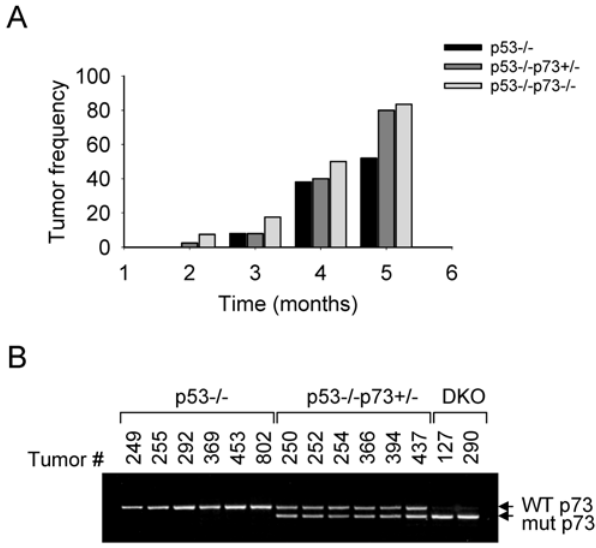
Figure 3. Loss of p73 promotes T cell lymphomagenesis independent of age. A. The dynamics of T cell lymphoma development in mice of the indicated genotypes. B. LOH analysis at the p73 locus by genomic PCR of tumor tissues derived from p53 2 / 2 , p53 + / 2 p73 2 / 2 , and p53 2 / 2 p73 2 / 2 (DKO) mice. Tumor numbers are